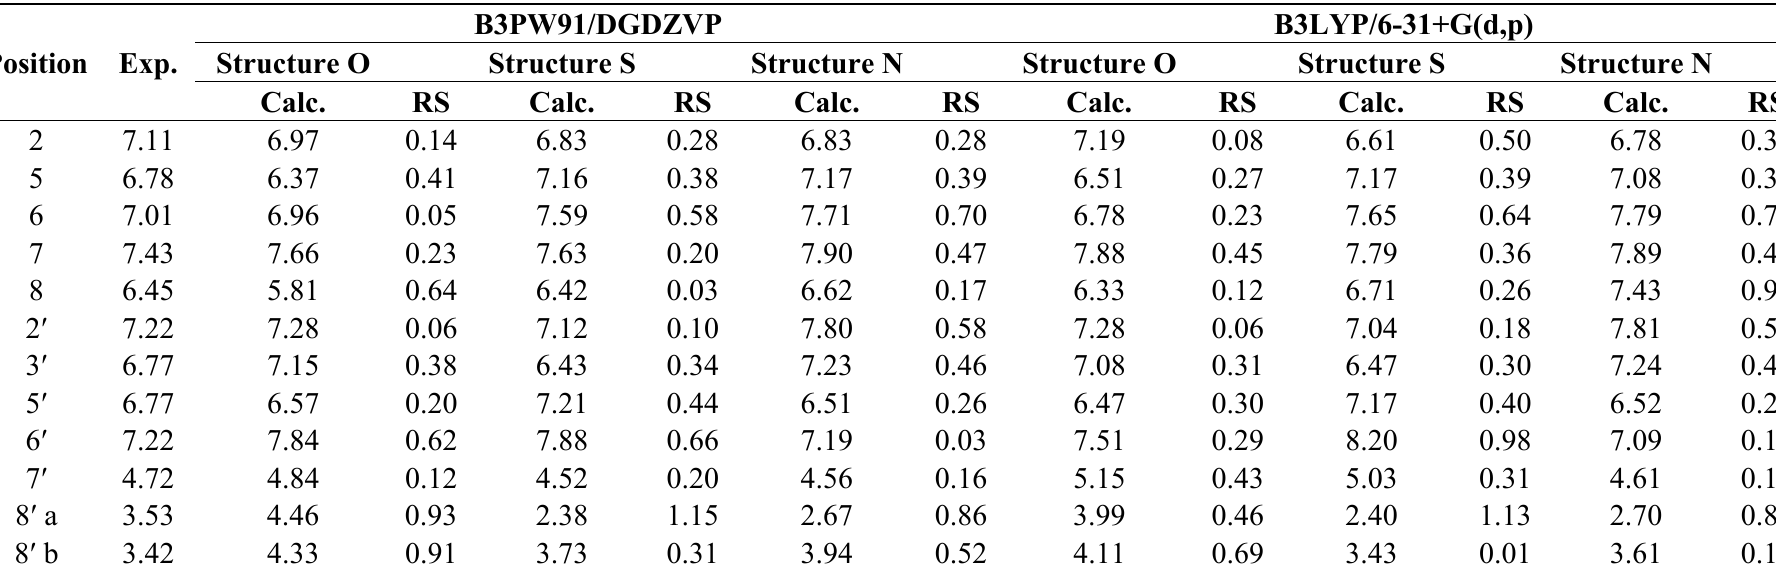
Table 2. Experimental ¹H NMR data (Exp.), calculated ¹H NMR data (Calc.) with B3PW91/DGDZVP and residue (RS) in ppm for the O , S and N